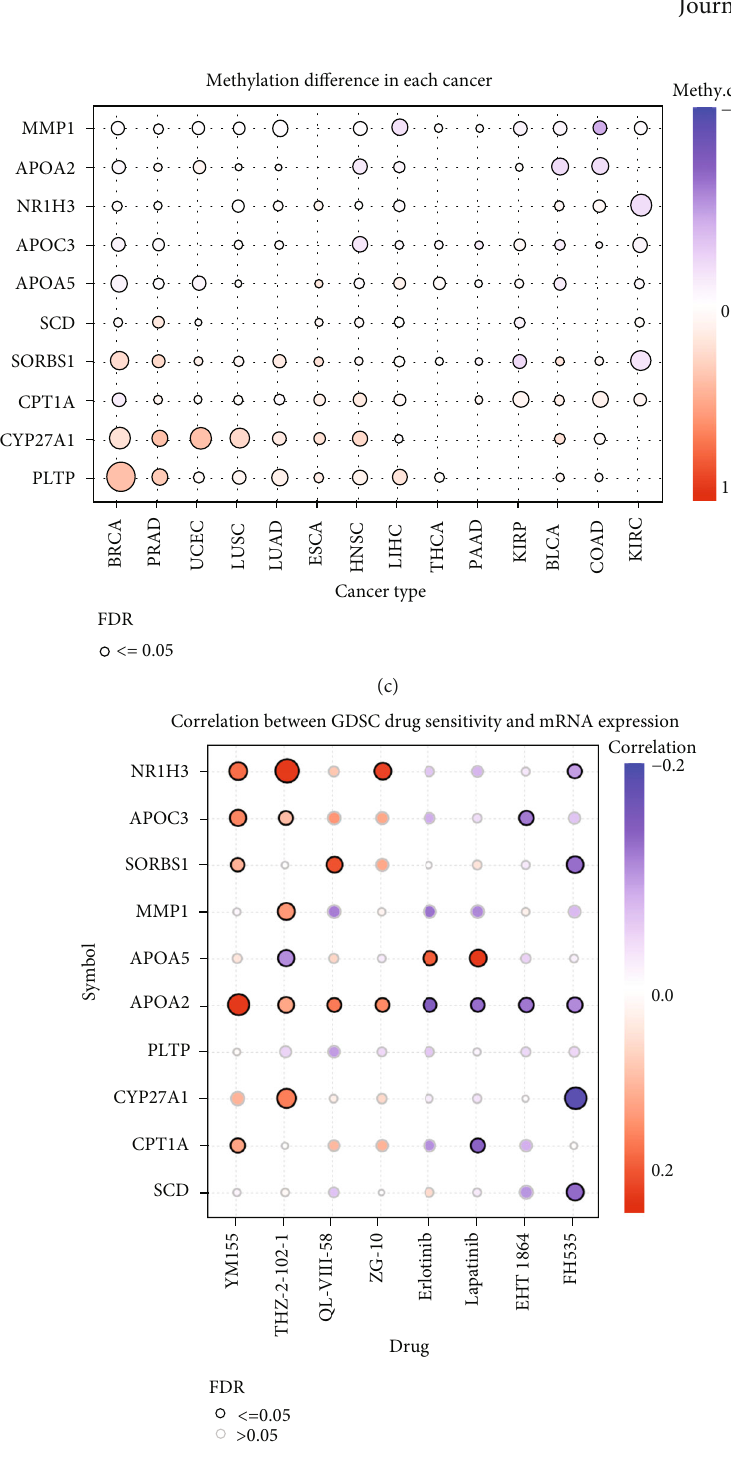
Figure 6: Immune in fi ltration analysis, methylation analysis, and drug sensitivity analysis of this risk model gene in pancancer. (a) The heat map shows the correlation between the risk model gene and immune cell in fi ltration in pancancer. It is worth noting that red represents positive correlation and purple represents negative correlation. ∗ P ≤ 0 : 05 and # FDR ≤ 0 : 05 . (b) The heat map shows the correlation between the risk model gene and immune cell in fi ltration in BRCA. Blue represents positive correlation, and pink represents negative correlation. ∗ P < 0 : 05 and ∗∗ P < 0 : 01 . (c) This shows the di ff erence in methylation of these risk model genes in multiple tumor types. (d) This shows the correlation between the risk model genes and the sensitivity of multiple anticancer drugs. Blue bubbles represent negative correlations, and red bubbles represent positive correlations; the deeper of color, the higher the correlation. There is a positive correlation between bubble size and FDR signi fi cance. The black outline frame indicates FDR ≤ 0 : 05